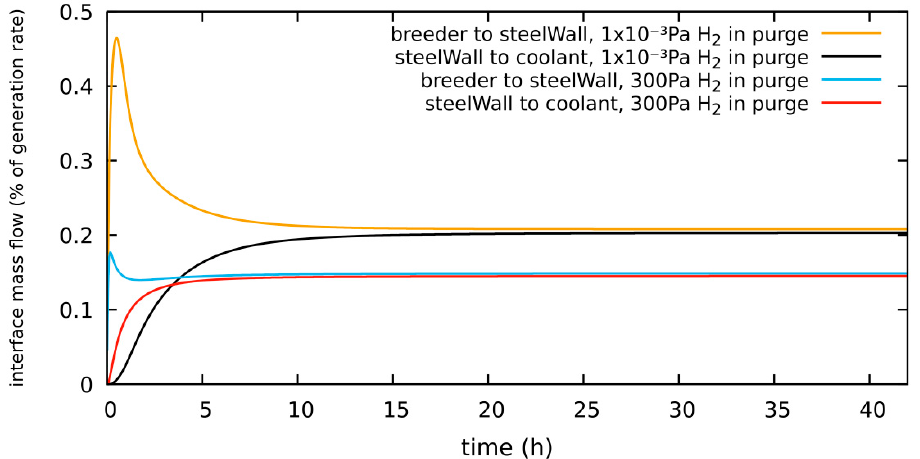
Figure 18. Transient T 2 and HT partial pressures at coolant outlet for 300 Pa H 2 in purge gas compared to T 2 in a single-species system (without H).